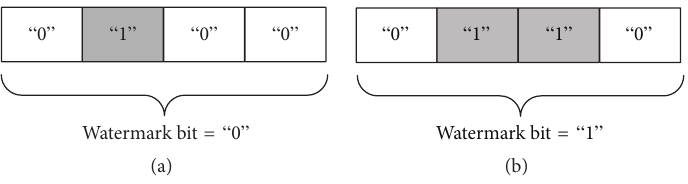
Figure 16: Four bits of “0100” are embedded into 4 subsegments of a frame, which represents embedding “0” (a), and 4 bits of “0110” are embedded into 4 subsegments of a frame, which represents embedding “1” (b).